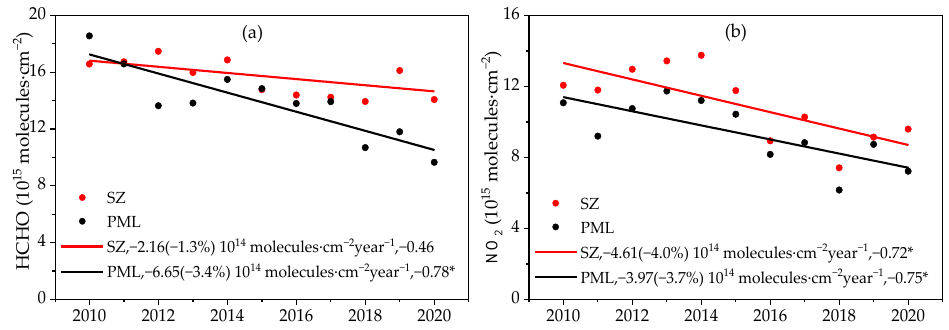
Figure 6. Trends in HCHO and NO 2 from the satellite observations in June for the period 2010 – 2020. Urban (SZ) and suburban (PML). Solid lines: linear fit curves. Inset: Annual linear trends in parentheses are the percentage rates and Spearman′s order correlation coefficients. Note: * indicates that the requirement of significance was reached ( p < 0.05). Figure ( a ) shows HCHO and Figure ( b ) shows NO 2 .